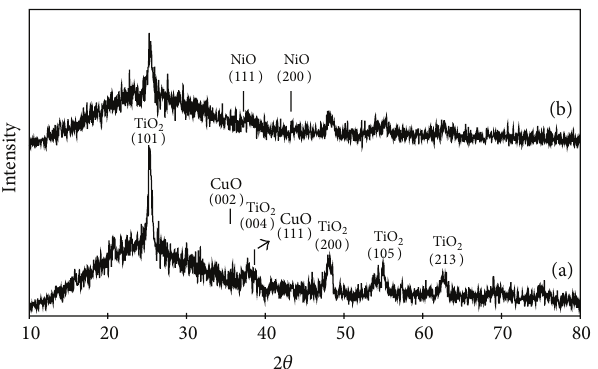
Figure 1: XRD patterns of (a) CuO and (b) NiO promoted nano-TiO 2